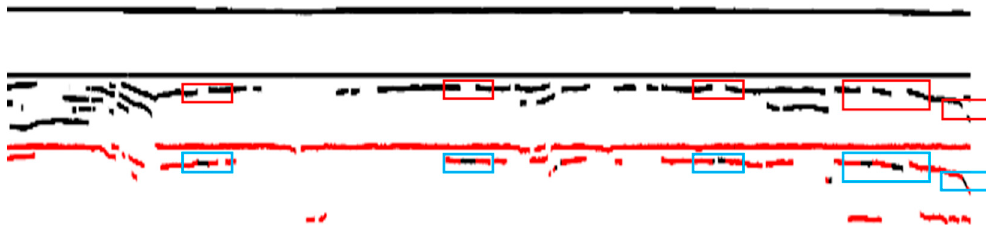
Figure 21. Horizons recovery using the multiples. The image (SBL_20120628_085229) is a part of the pseudo-Radon transformed image after correlation analysis. The black lines are marked as horizons, and the red are multiples. The red rectangles are horizon discontinuities, and the blue are multiples discontinuities.